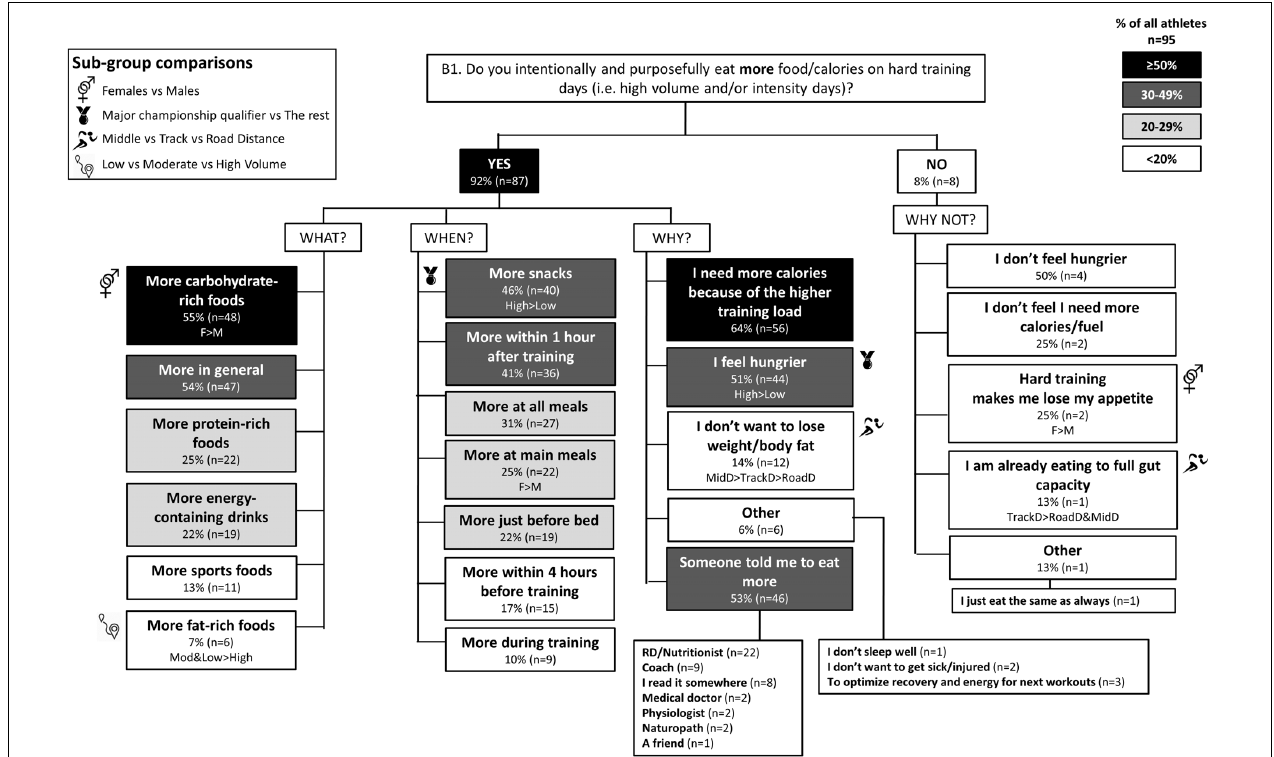
FIGURE 2 | B1: Nutrition on hard training days during base training phase. The prevalence of specific nutrition practices on hard training days and the reasons for following them in 95 elite female and male track and field endurance athletes. Please see full description for figure within Figure 1 .